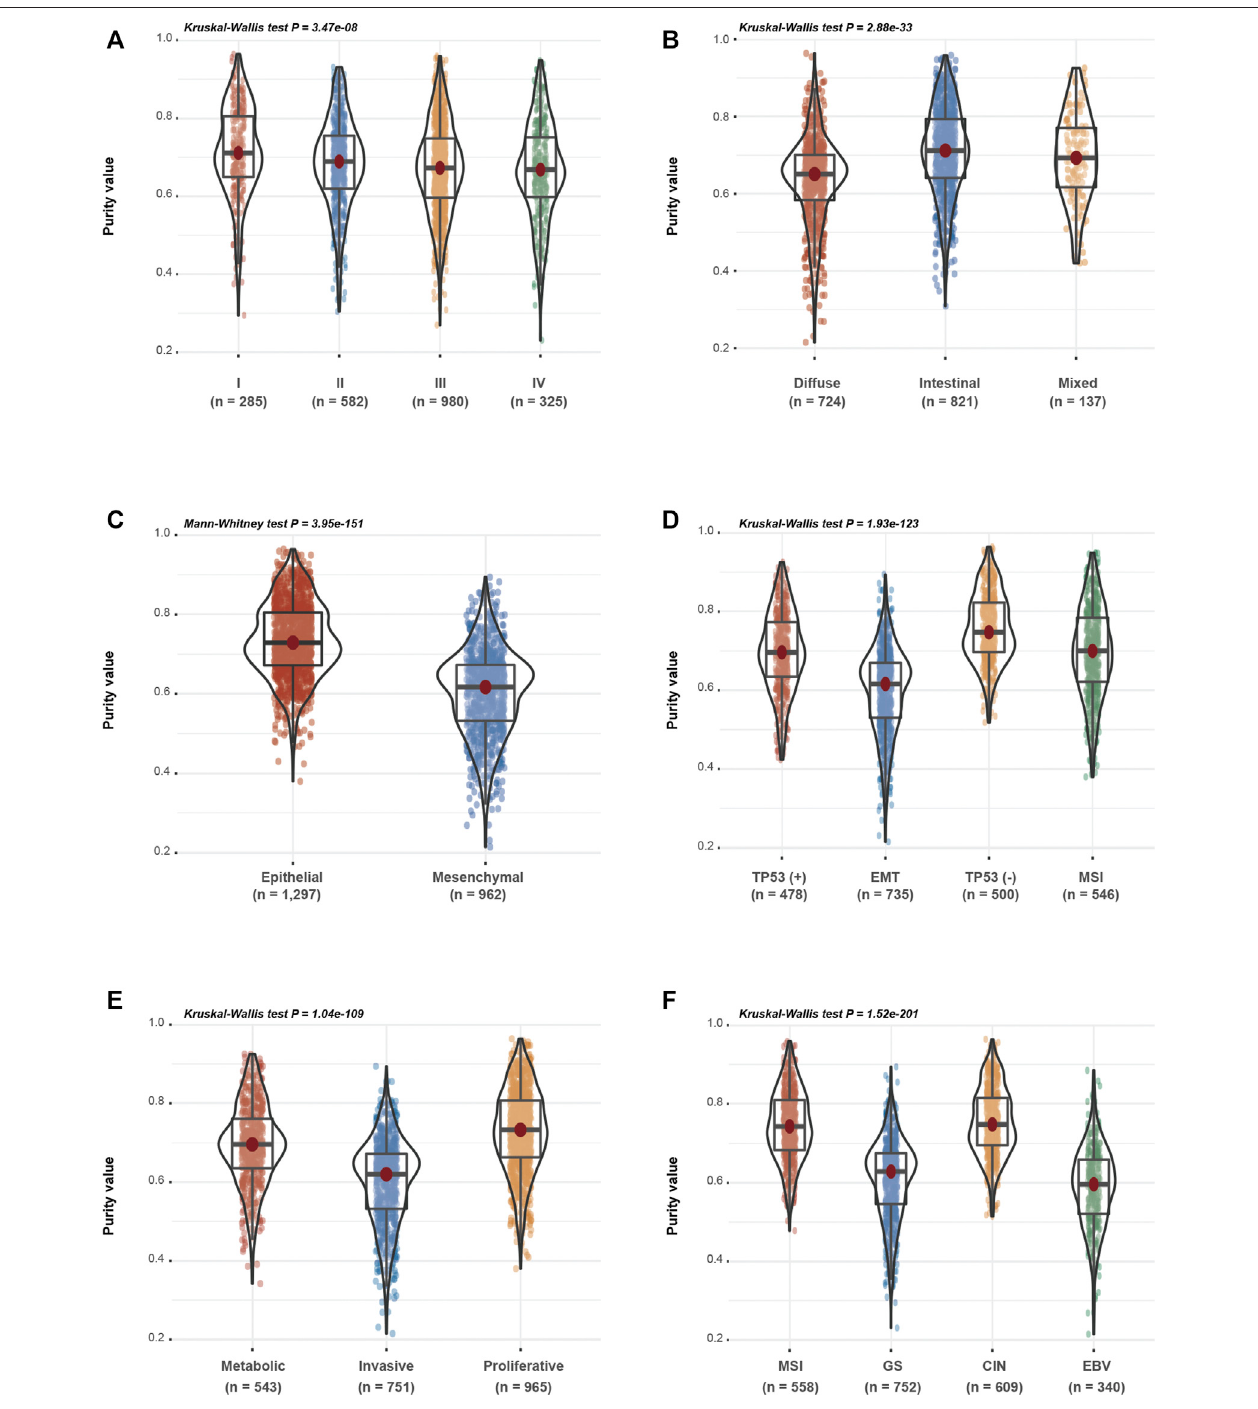
FIGURE 2 | Gastric cancer (GC) purity is characterised by speci fi c clinicopathological and molecular features. (A – F) Distribution of GC purity in terms of (A) TNM stage, (B) Lauren classi fi cation, (C) EM (epithelial and mesenchymal) subtype, (D) ACRG subtype, (E) Singapore subtype and (F) TCGA subtype. The upper and lower ends of the boxes represent the inter-quartile range of values. The linesin the boxes represent the median value. The whisker edges are the last data points within 1.5 of the inter-quartile range. The horizontal width of the violin represents the data density.